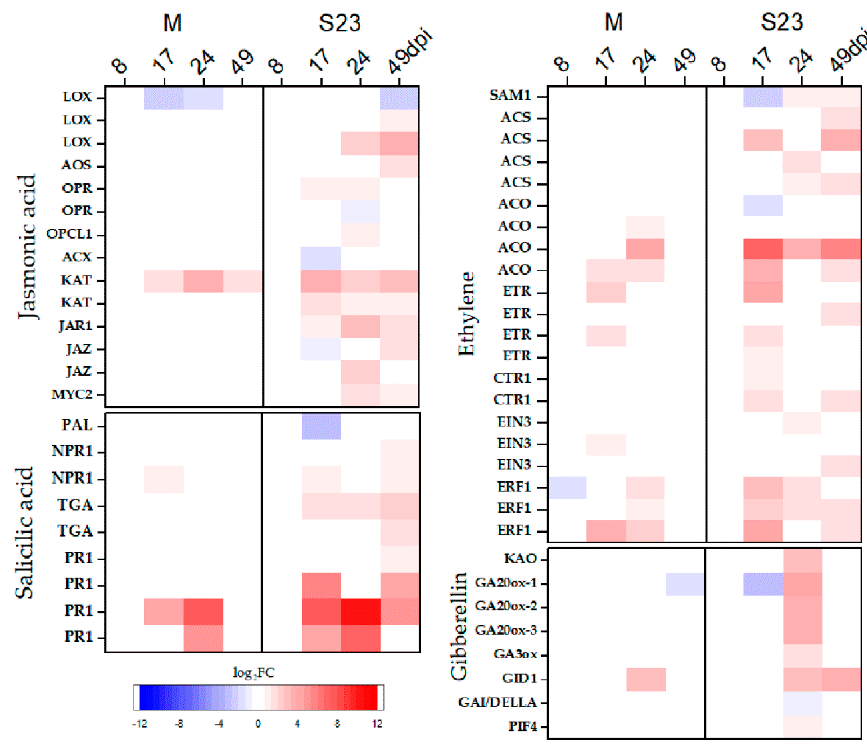
Figure 6. Heat map of log 2 fold change of DEGs involved in plant hormone biosynthesis and signaling. Only selected hormones are presented.